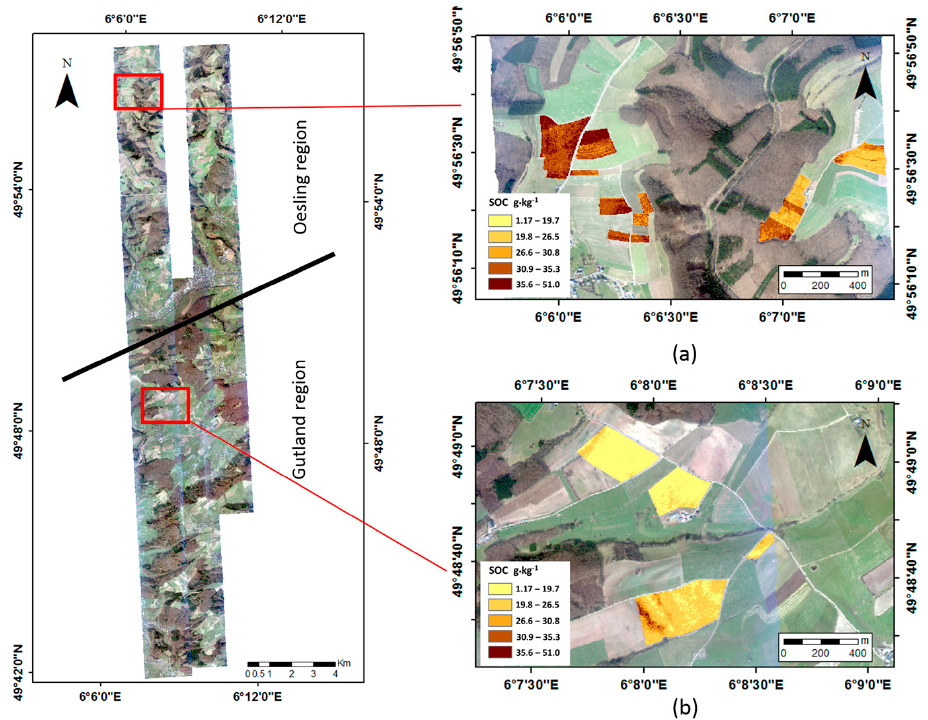
Figure 6. RGB (red: 661 nm; green: 545 nm; blue: 450 nm) airborne images acquired by APEX sensor in Luxembourg (left), and some SOC maps obtained by the bottom-up approach in the northern ( a ), and central ( b ), areas.